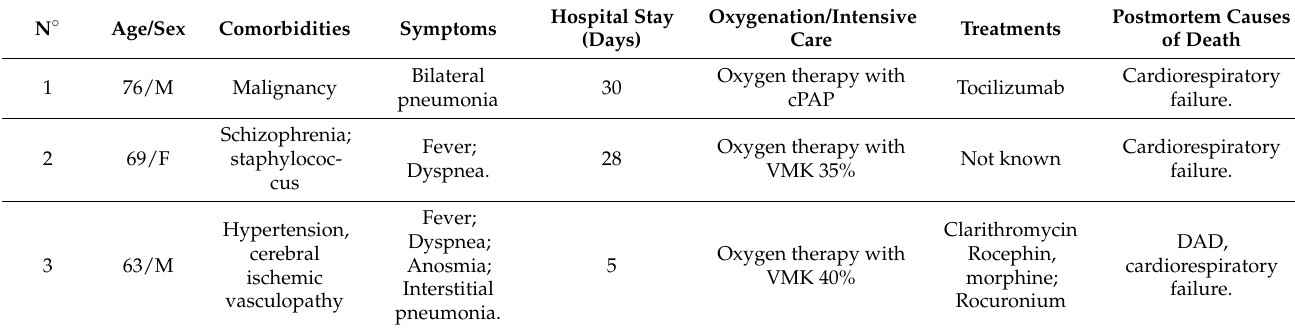
Table 2. Demographics and clinical course of deceased COVID-19 patients.